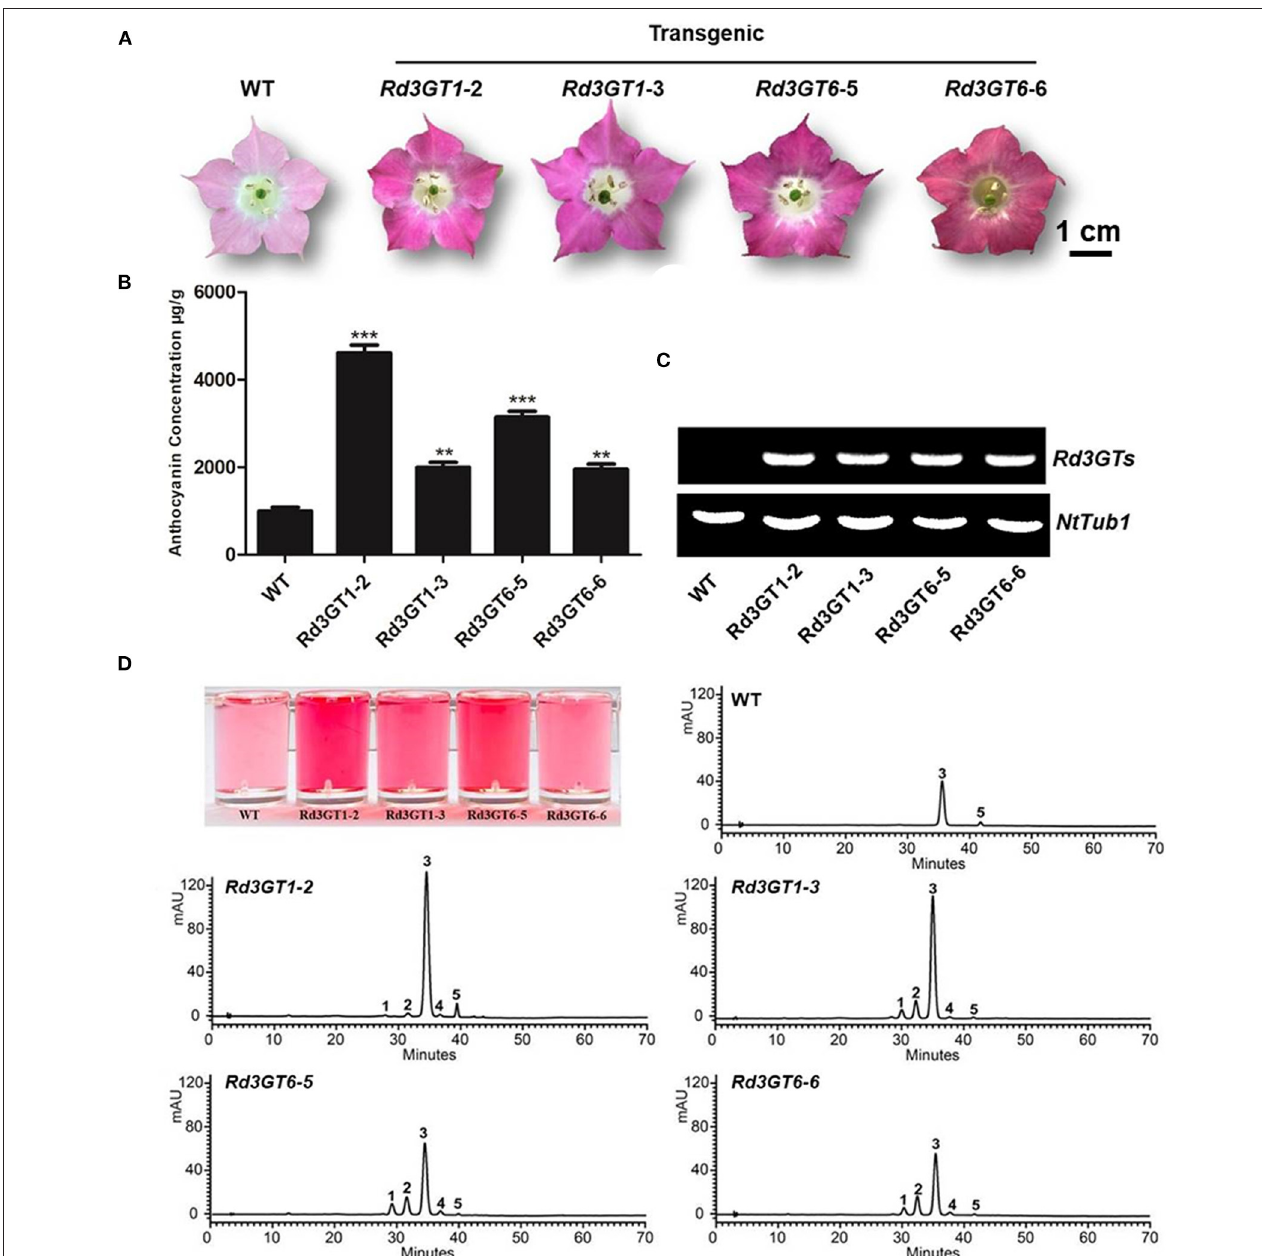
FIGURE 6 | Effect of Rd3GT1 and Rd3GT6 on anthocyanin accumulation in transgenic tobacco flowers. (A) Tobacco flowers of wild-type and transgenic lines. (B) Contents of anthocyanin accumulation in transgenic tobacco flowers with HPLC. (C) Expression confirmation of Rd3GT1 and Rd3GT6 in flowers of transgenic tobacco. (D) HPLC analyses of anthocyanins in transgenic tobacco flowers. 1, Cyanidin 3- O -rutinoside 5- O -glucoside; 2, Cyanidin 3- O -arabinoside; 3, Cyanidin 3- O -rutinoside; 4, Cyanidin 3- O -xyloside; 5, Cyanidin 3- O -(6- O -malonyl-beta-D-glucoside). Results correspond to means from three biological replicates. Asterisks indicate significant differences between means of wild-type and transgenic plants calculated by Student’s t -test (** p < 0.01); *** p <